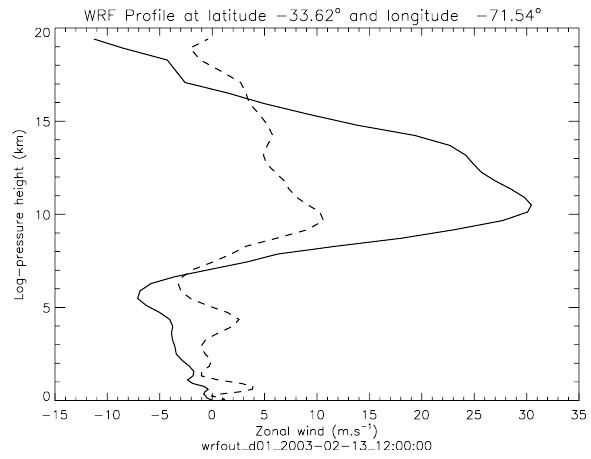
Fig. 6. Case 1: Results of the WRF simulations. Velocity profiles (ms − 1) at the nearest grid point to Santo Domingo. Full line: zonal wind, dashed line: meridional